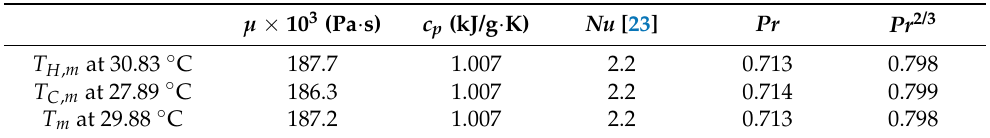
Table 5. Thermophysical properties of the